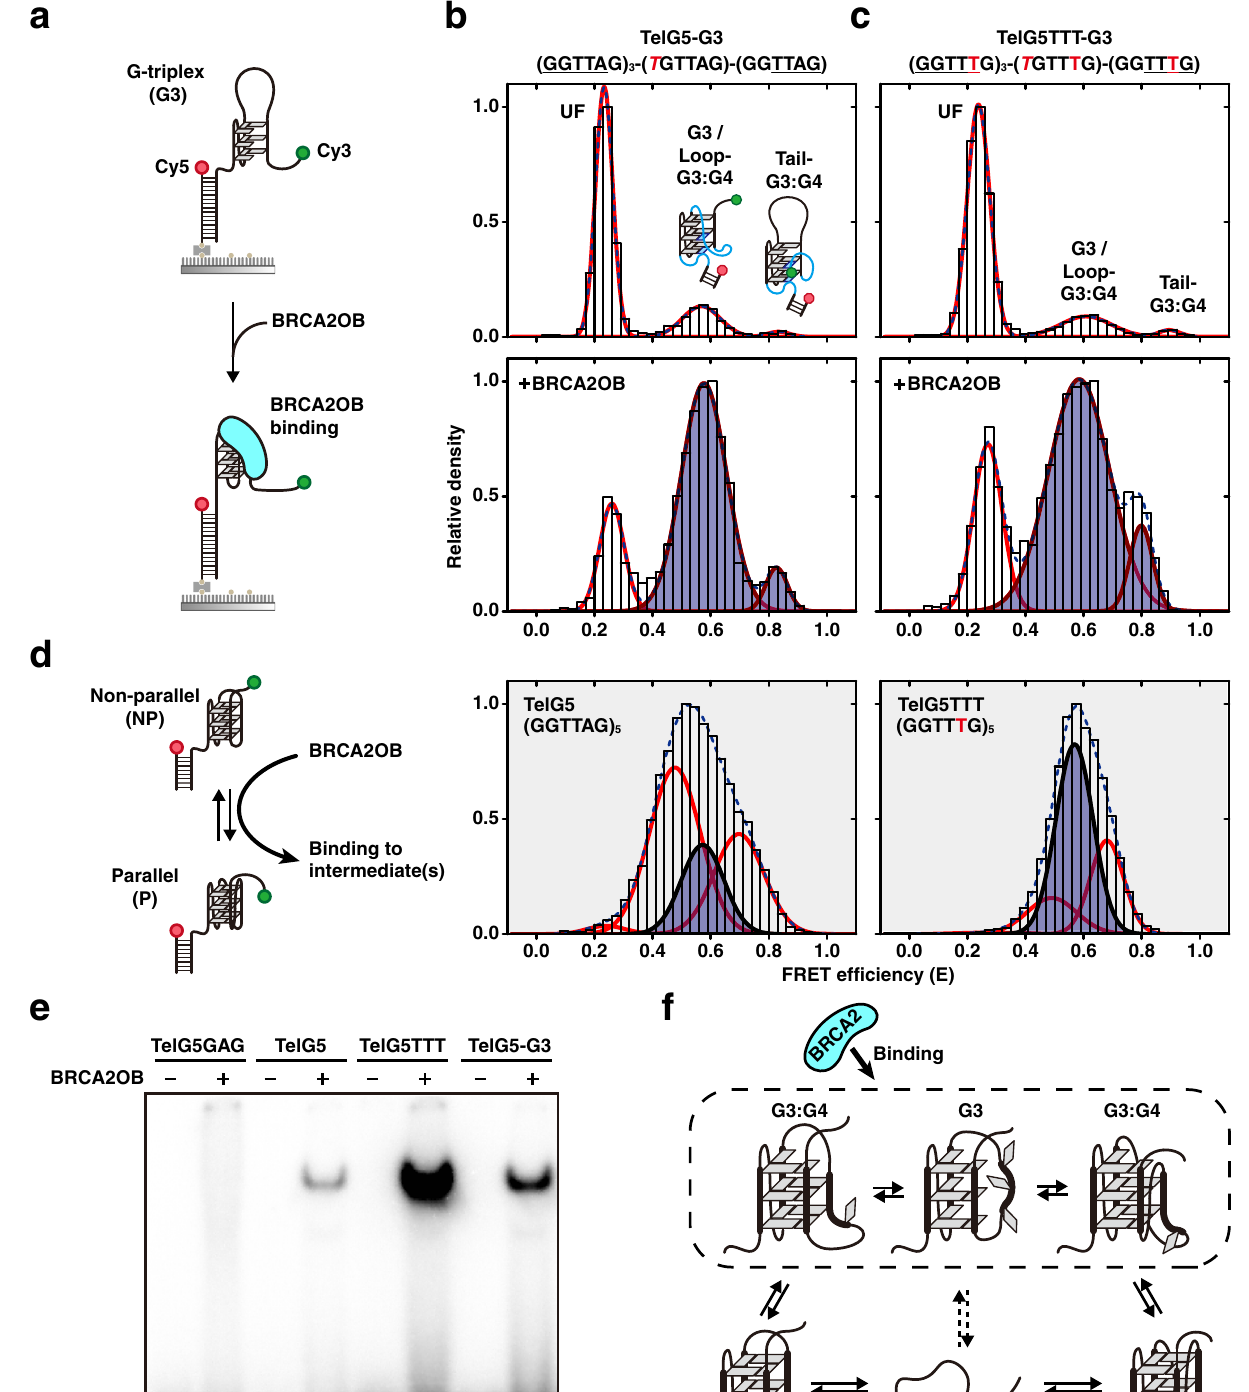
results con fi rm that the interaction of BRCA2 with telomere G4 is innate to its tumor suppressor